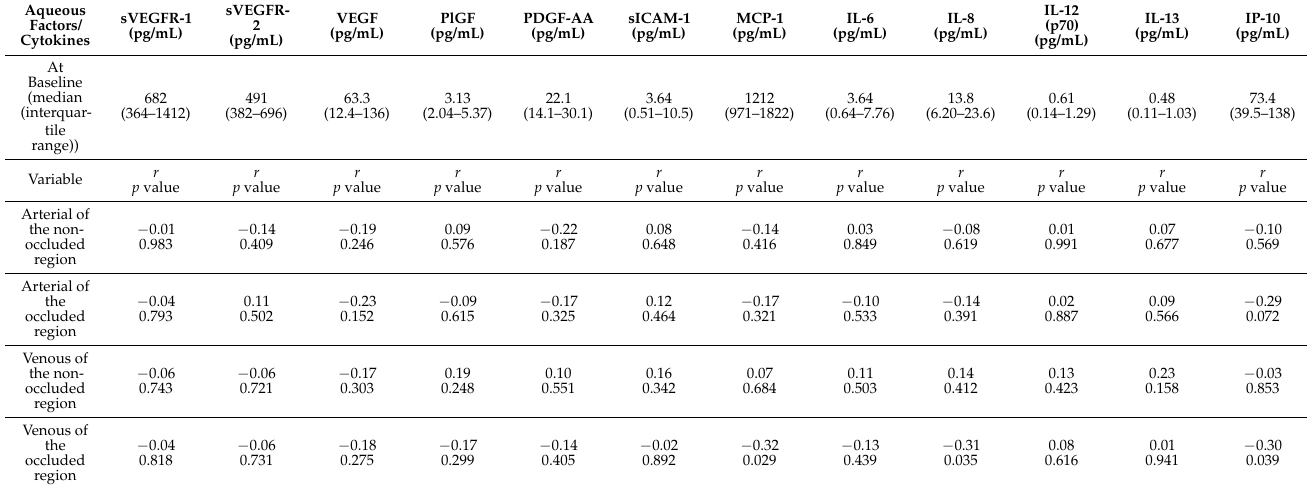
Table 2. Aqueous humor levels of factors/cytokines and the aqueous flare value at